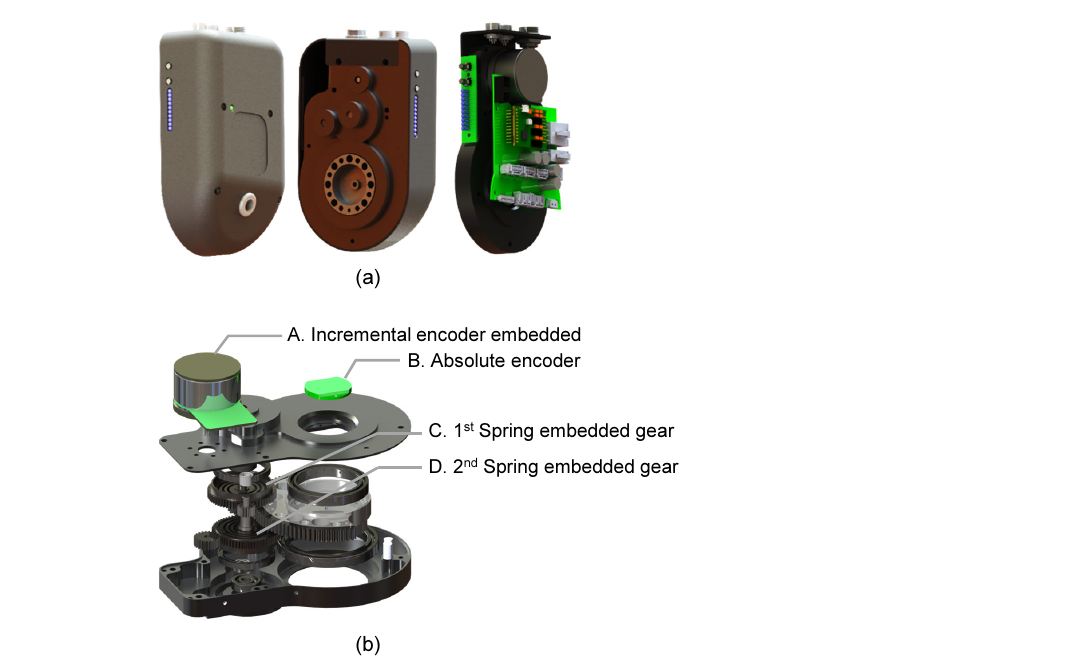
Figure 2. AngelJoint v1: ( a ) the outside view and ( b ) the structure of the series elastic actuation system. Table 1. Specification of Angel Joint